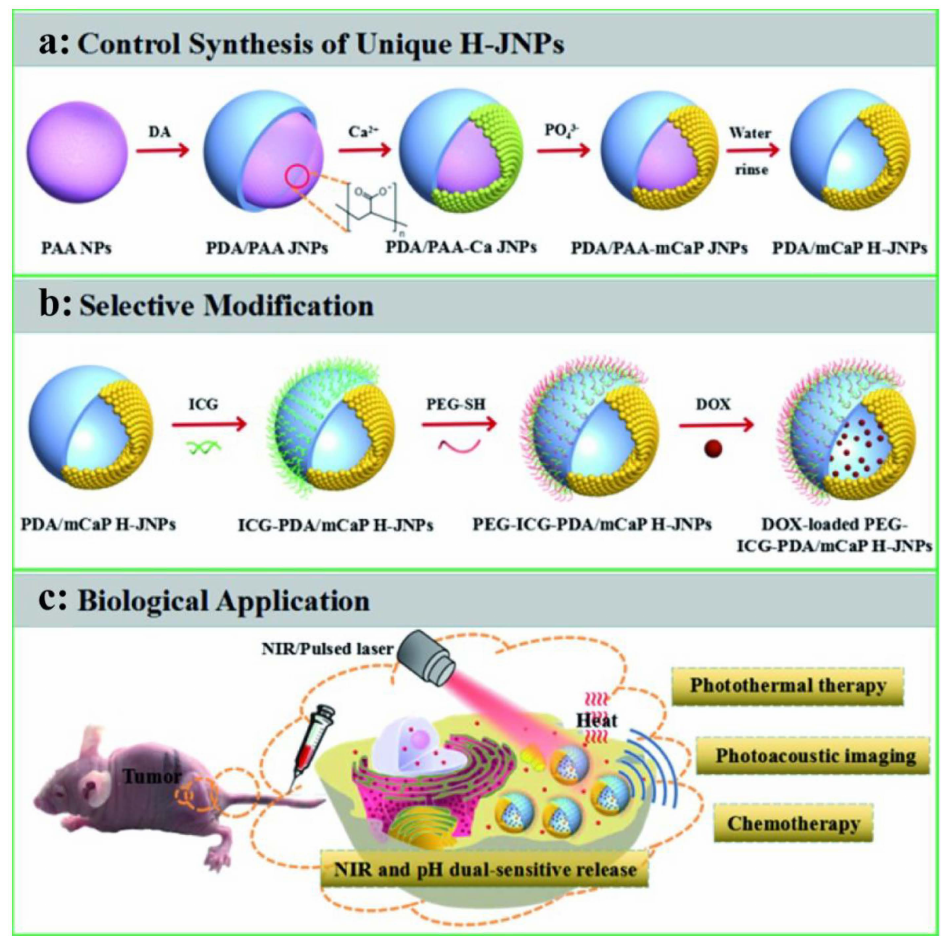
Figure 10. The controlled synthesis of PEG-ICG-PDA/mCaP H-JNPs ( a ) and biofunctionalization of multifunctional H-JNPs ( b ). ( c ) PA imaging-guided chemo-photothermal synergistic cancer therapy